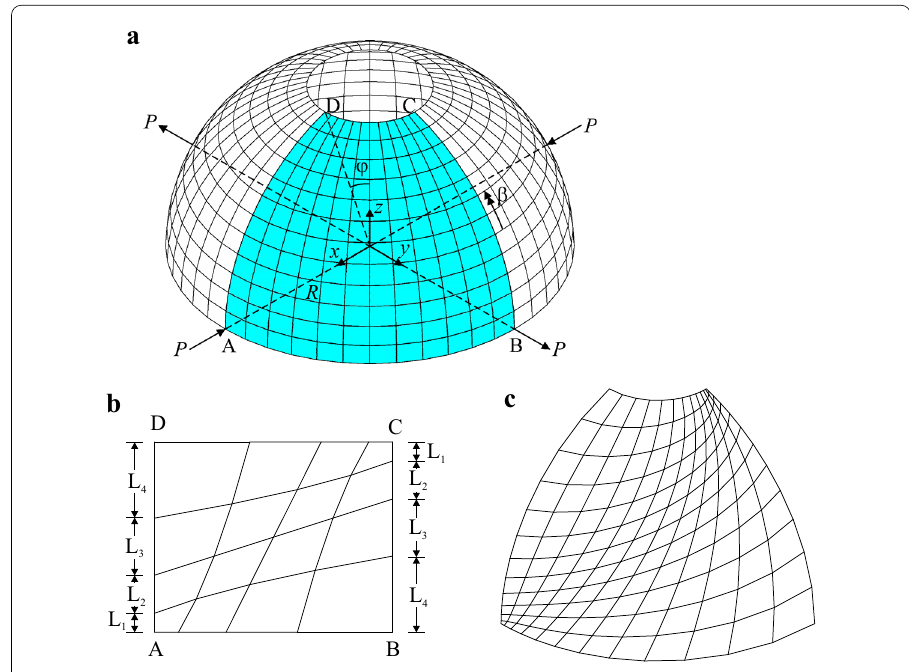
Fig. 6 Hemispherical shell: a 12 × 12 regular mesh, b principal mesh distortion for a 4 × 4 mesh, c 12 × 12 distorted